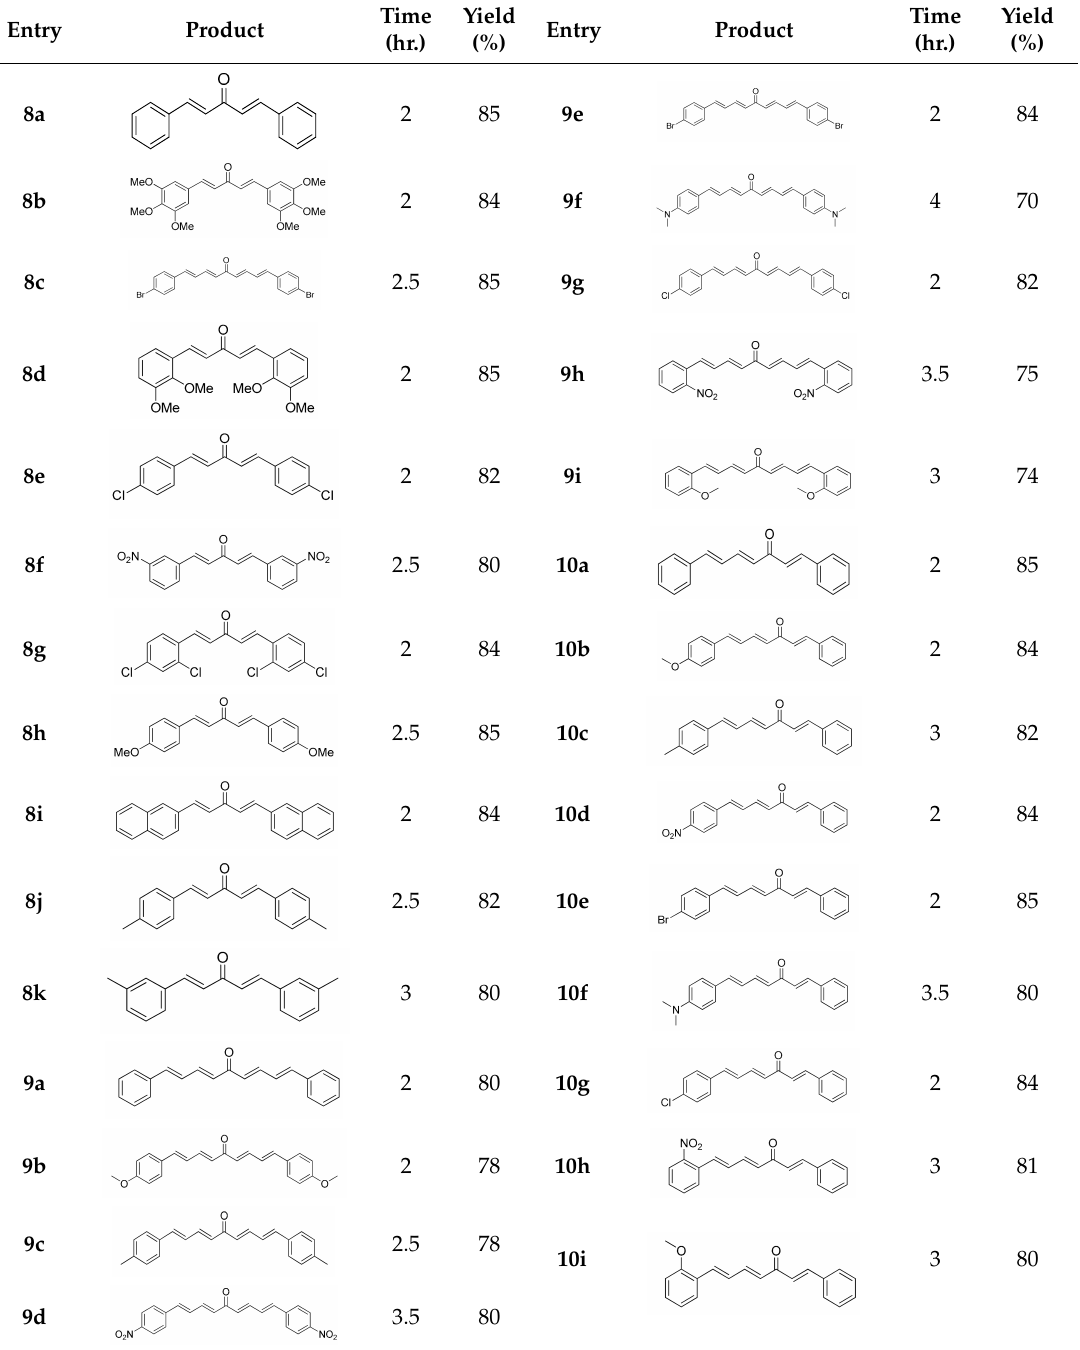
Table 1. Synthesis of a series of curcumin analogues.